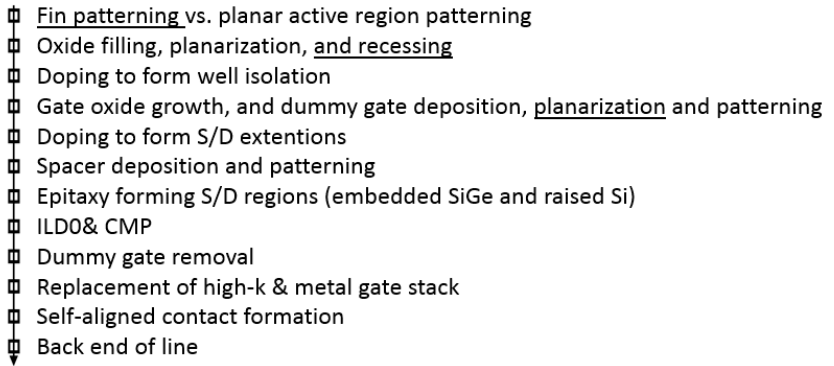
Figure 1. Process flow for the bulk fin field effect transistors (FinFETs) or planar transistors where additional processes for FinFETs are underlined.